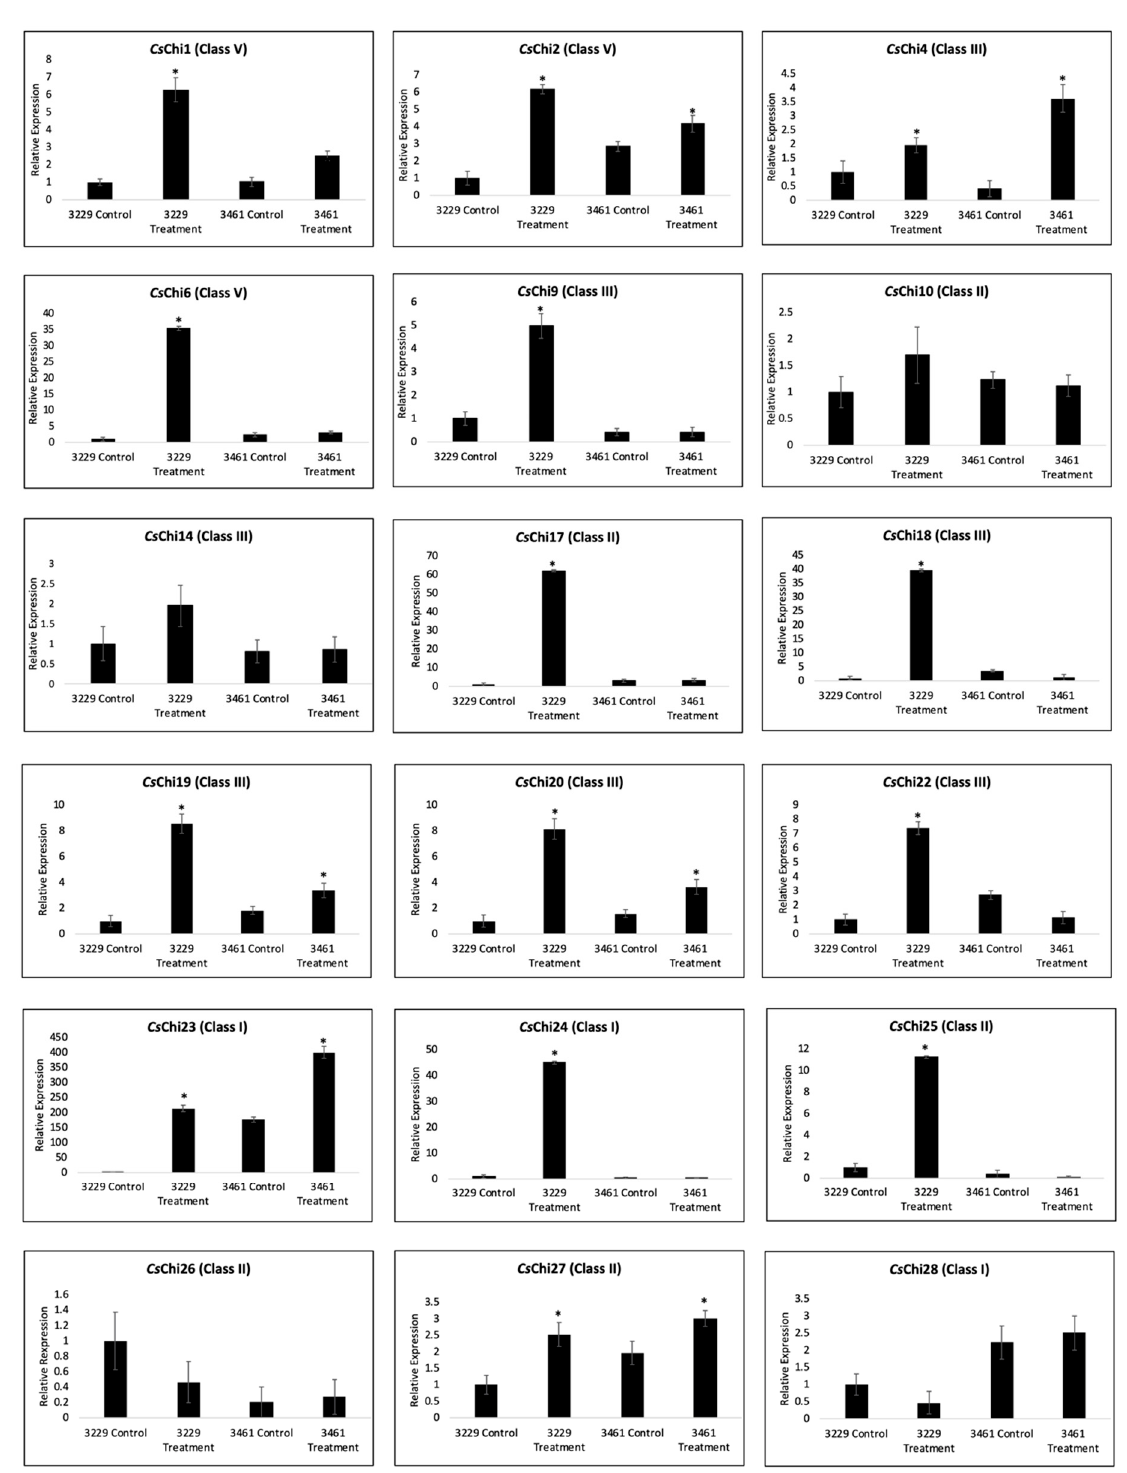
Figure 6. Expression patterns of 18 chitinase genes in C. sativus lines 3229 (susceptible) and 3461 (resistant) after infection with F. oxysporum f. sp. cucumerinum Owen race 3. Data were normalized to the expression level of β -actin. All data points are the means ± SE ( n = 3). (*, p < 0.05; Student’s t -test). 247